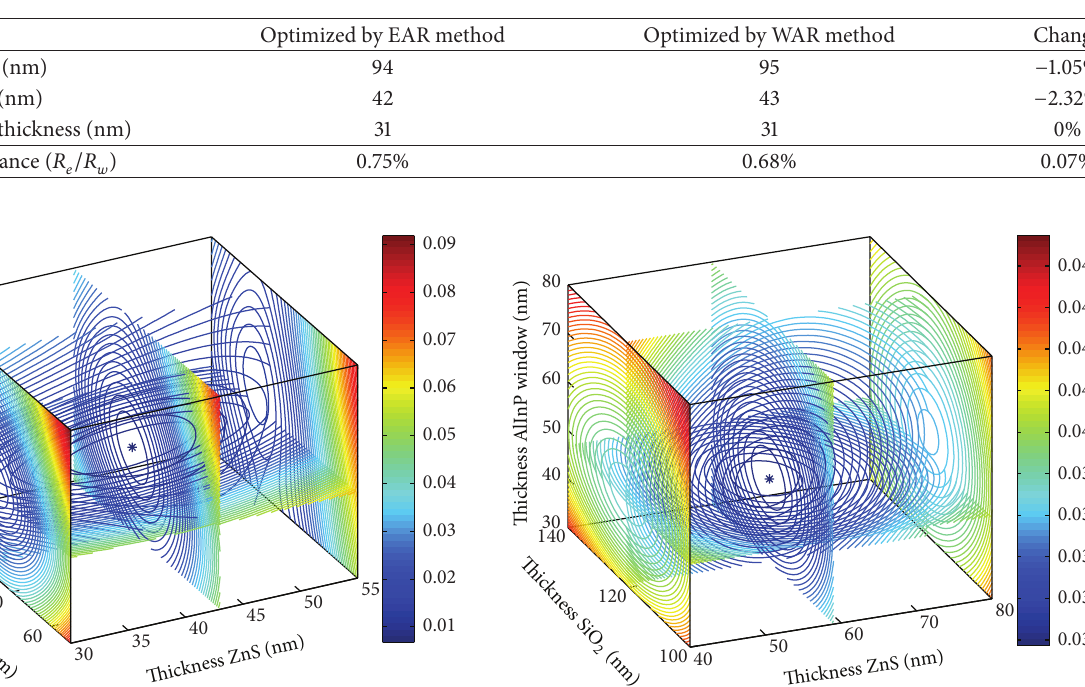
Table 1: Comparison of parameters of SiO